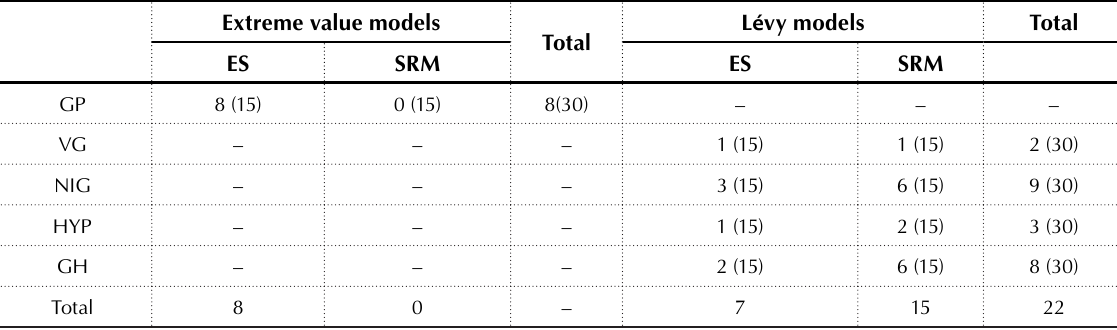
Table 5. Frequency distribution of significant estimates of ES and Lévy spectral risk